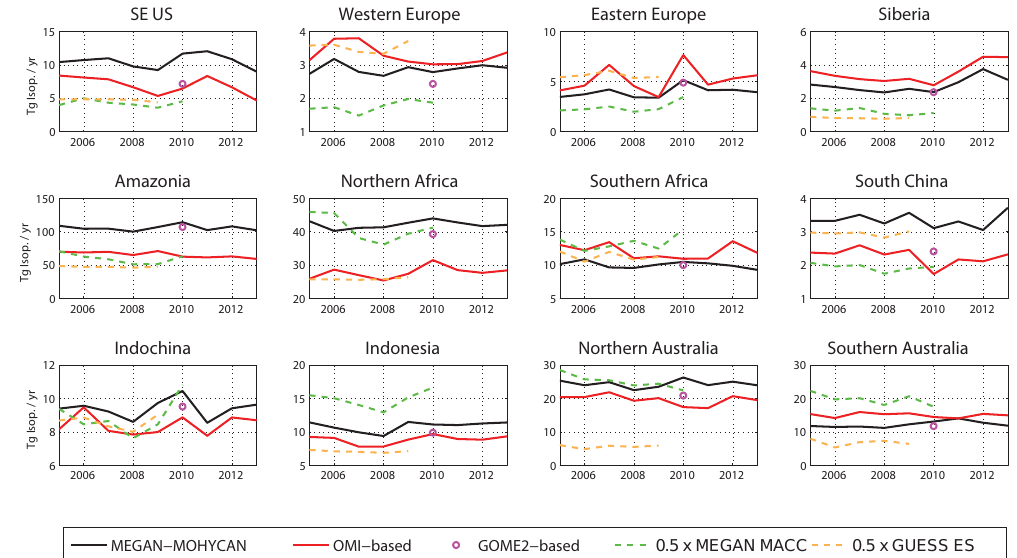
Figure 8. Interannual variation of isoprene fluxes over 2005–2013 from the a priori inventory (black), the satellite-based estimates (OMI in red), MEGAN-MACC (in green), and GUESS-ES (in orange) over regions (red boxes) defined in Fig. 3. Units are Tg of isoprene per month. The GOME-2-inferred estimate is shown as magenta